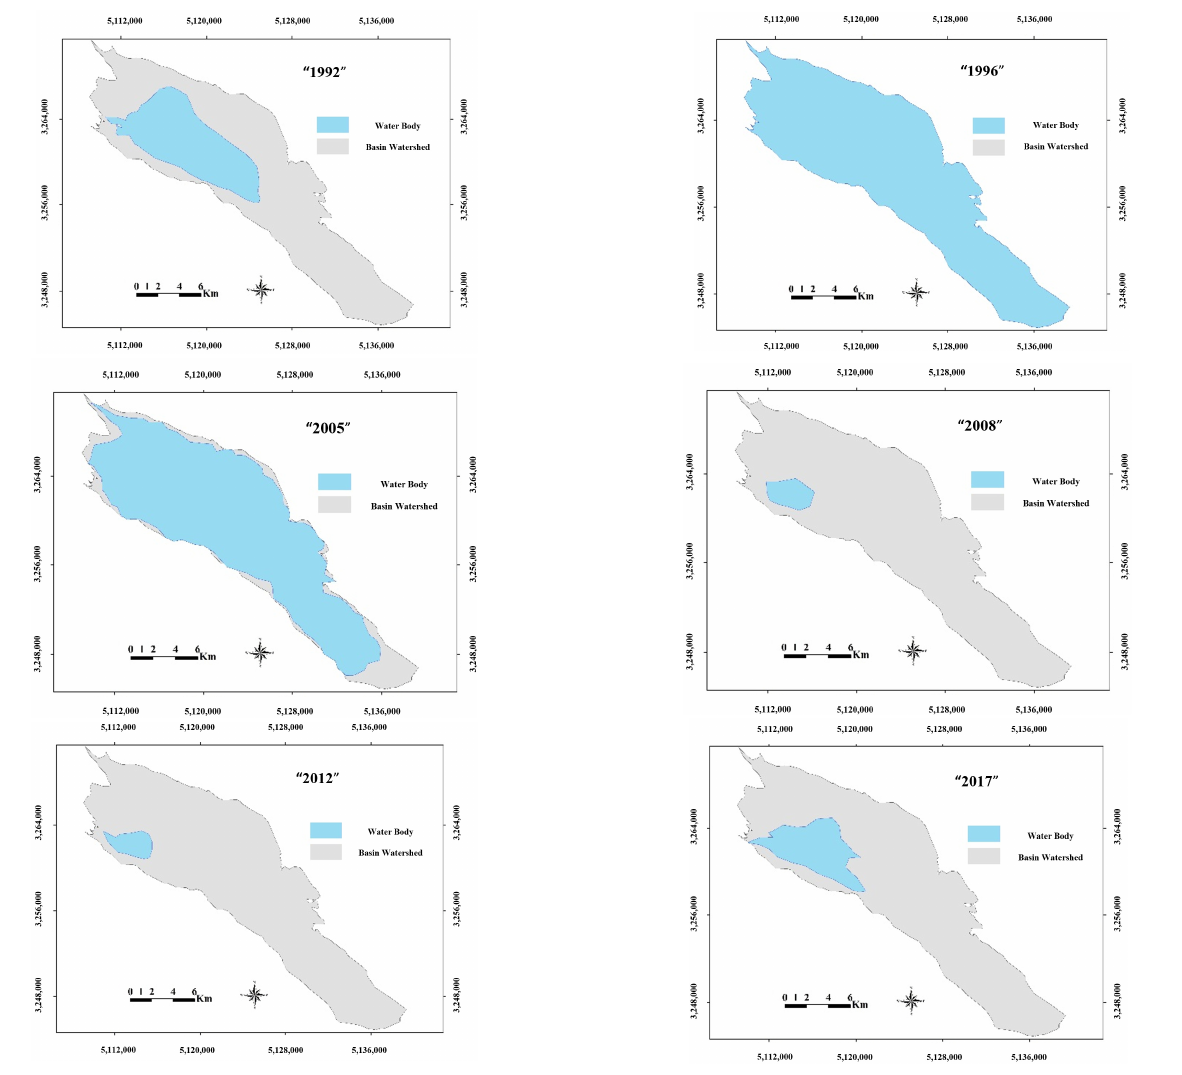
Figure 7. Change detection of Maharlou Lake’s surface. Table 3. Detected trend component in the lake’s surface area time series.